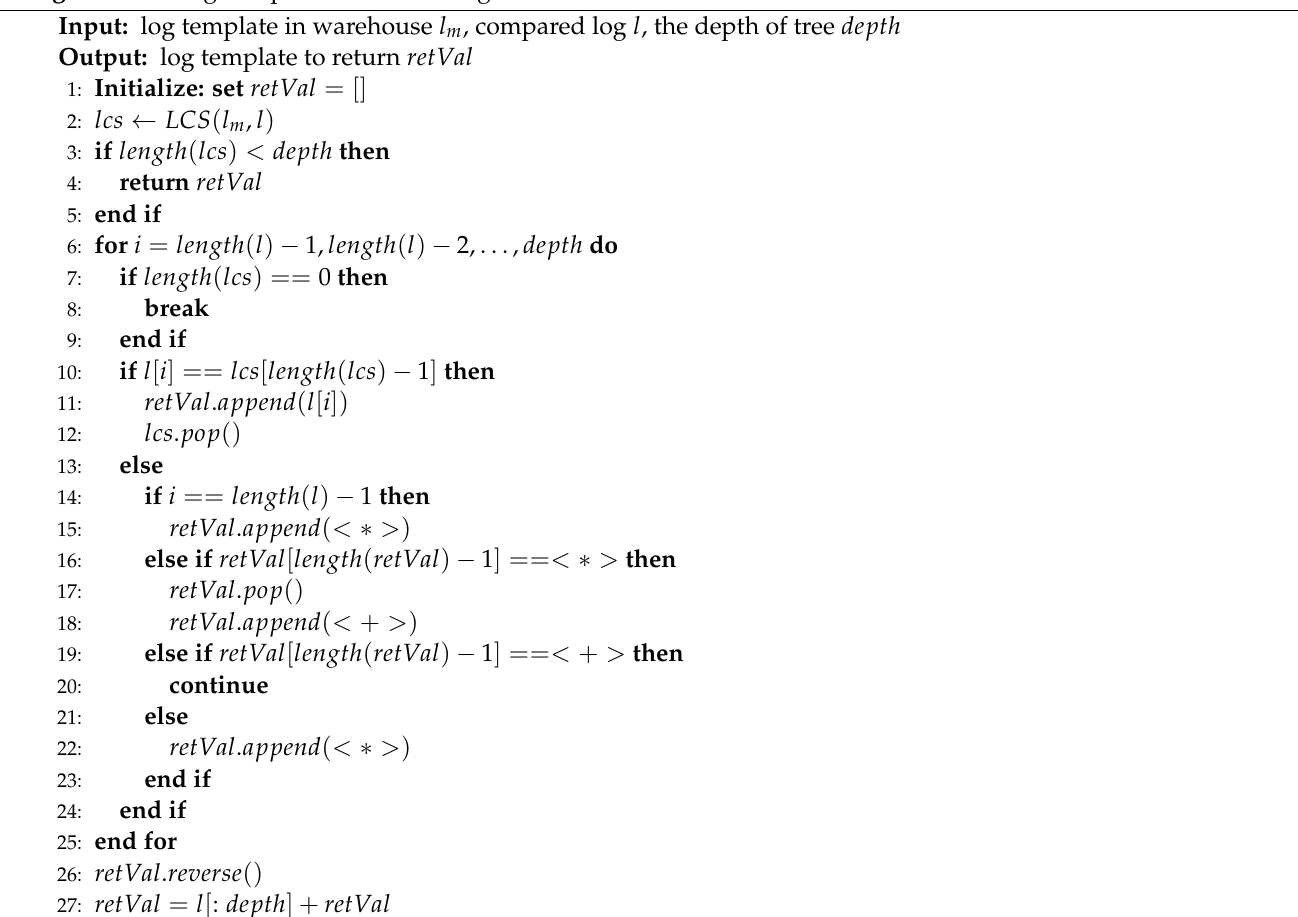
Algorithm 2: Log Template Extraction Algorithm Based On Tree